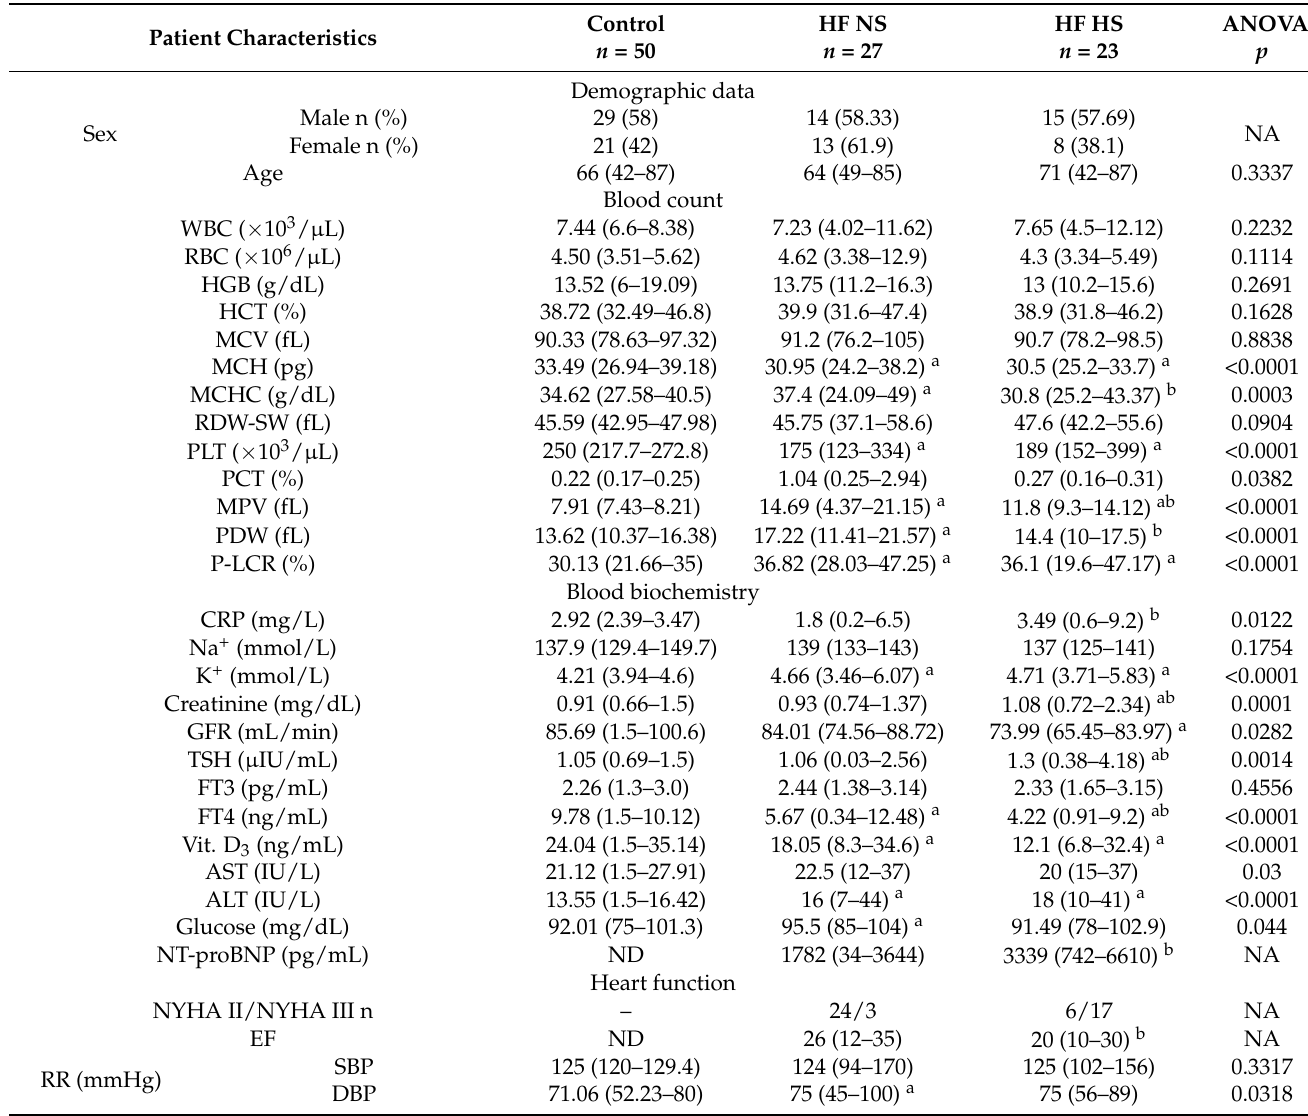
Table 1. Clinical characteristics of heart failure (HF) patients and the control